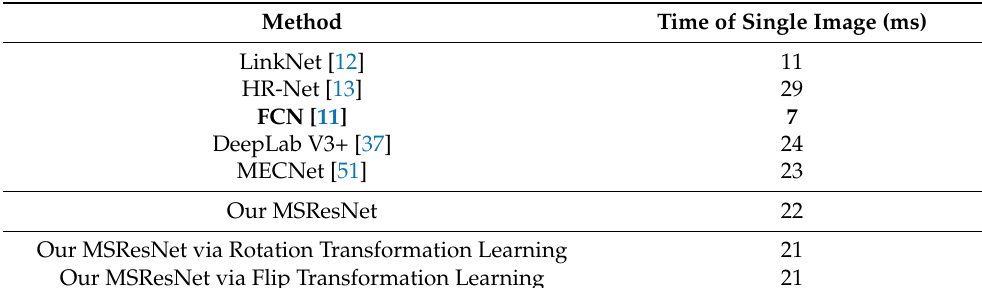
Figure 9. Visible water-body detection of the GID dataset. ( a , b ) are raw images and ground truth, respectively. ( c , d ) are the results of LinkNet and the results of HR-Net, respectively. The results of FCN and the results of DeepLab V3+ are shown in ( e , f ), respectively. ( g ) The results of MECNet, and ( h ) the results of our MSResNet. The results of our proposed MSResNet via rotation transformation learning and flip transformation learning are displayed in ( i , j ), respectively. Table 6. The times for detecting water bodies from one single image by different methods on the GID